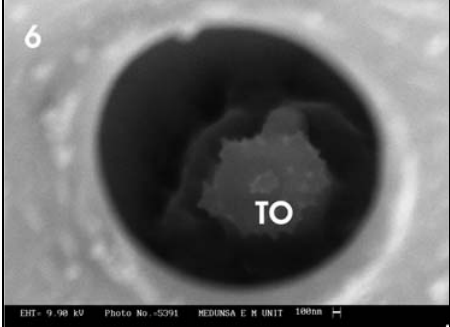
Fig. 6. The enlarged pit organ (tuft organ)(TO) with- in the sensilla